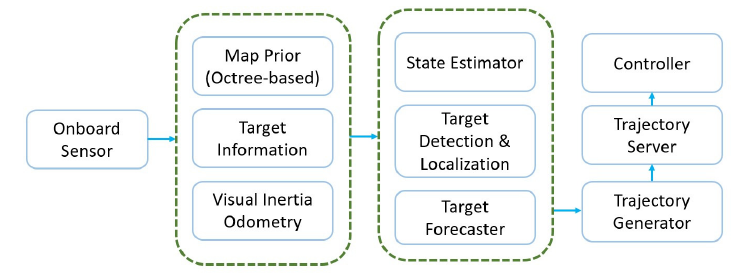
Figure 1. UAV path planning approach architecture